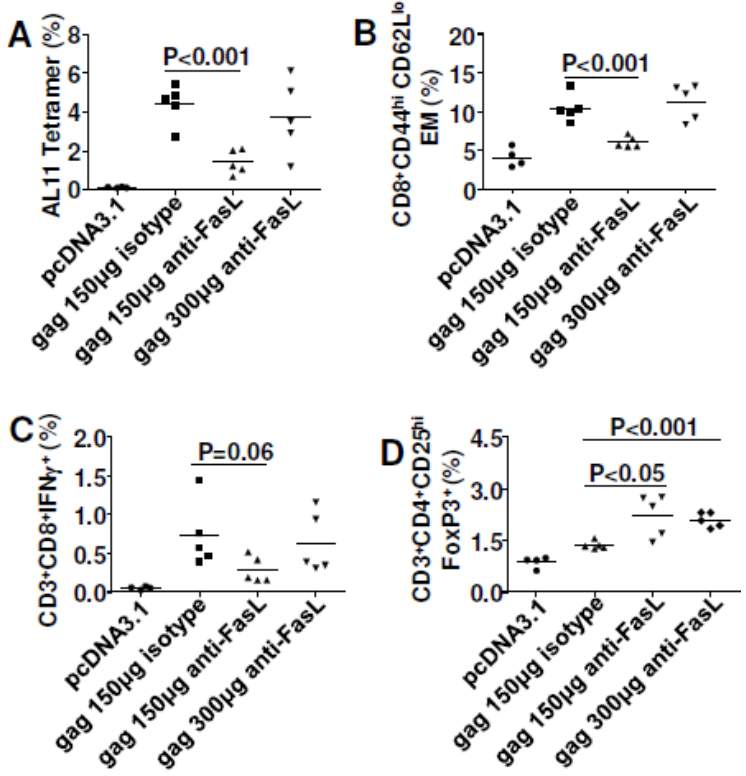
Figure 3. In vivo anti-FasL neutralization did not improve CMI responses for SIVmac Gag. C57BL/6 mice were immunized with 2 μg plasmid pJ603-gag at day 0 and day